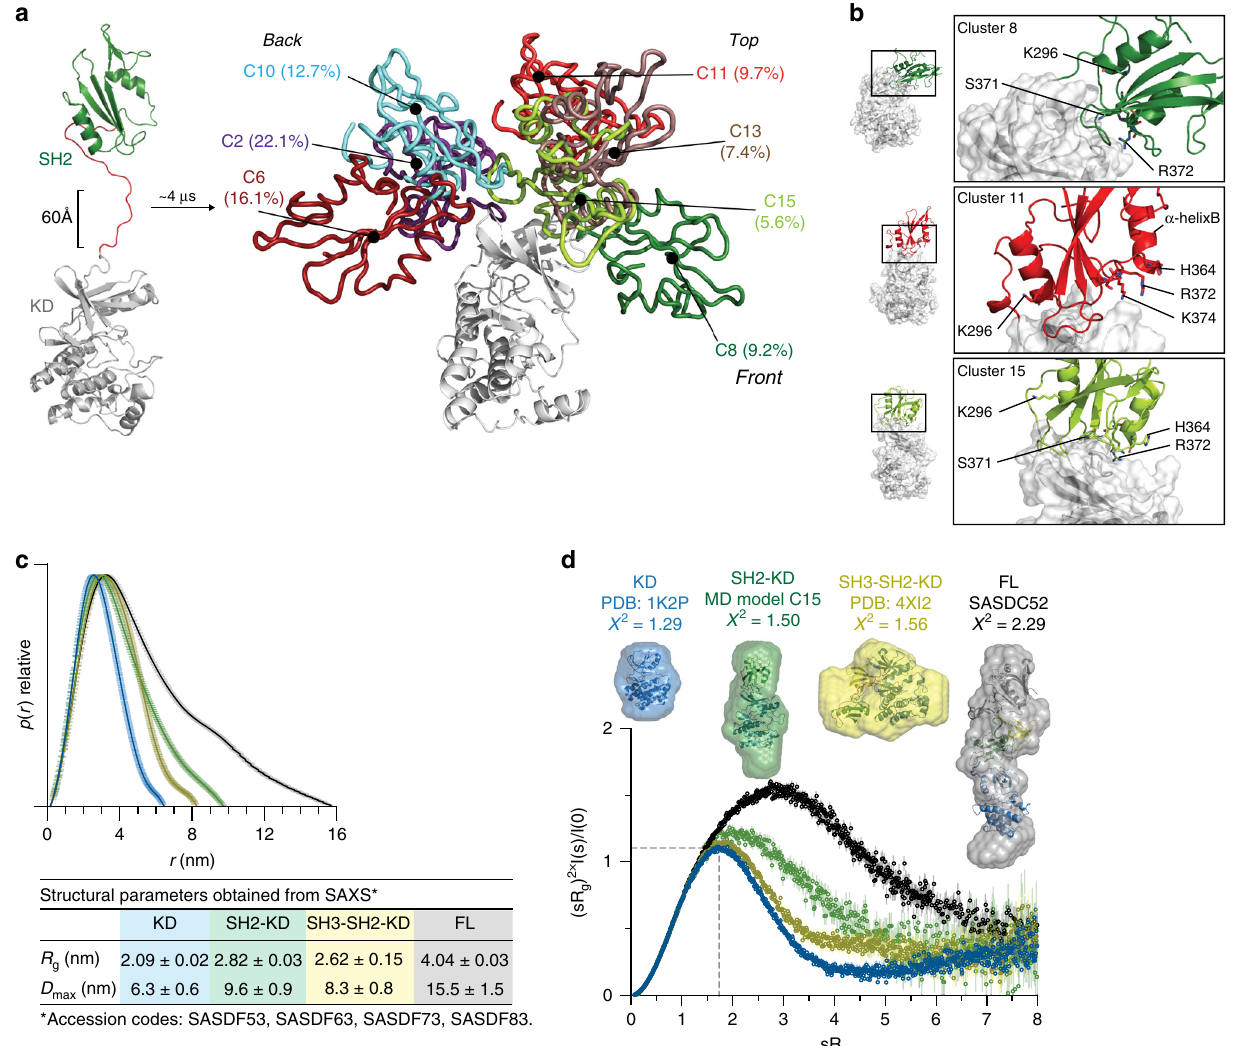
Fig. 3 SH2 domain interacts with the N-lobe of the KD in the active Btk. a Scaled MD simulations were performed using a model including the Btk SH2 and KD crystal structures (PDB 6HTF and 1K2P, respectively). The most populated clusters of the SH2 positions (several colors) relative to the KD (white) are shown. The percentages indicate the population of the cluster with respect to the entire simulation time. b Detailed view of the SH2-KD interface of clusters 8, 11 and 15. SH2 residues mutated in XLA are indicated as sticks. c Comparative maximal particle dimension ( D max ) of recombinant Btk proteins and summary of structural paraments ( R g and D max ± error) obtained from SAXS. See Supplementary Table 2 for details. d Dimensionless Kratky plot of recombinant Btk proteins. The gray dashed line represents the theoretical peak assuming an ideal Guinier region for a globular particle. Ab initio envelope reconstructions obtained from SAXS (surface representation) superimposed on the crystal structures for Btk KD and SH3-SH2-KD (PDB 1K2P and 4XI2, respectively) are shown on top. For the SH2-KD protein, the structure of an elongated MD model with the best agreement with the experimental SAXS data is shown (model C15 shown in a and b ). FL protein shows an extended conformation as observed in a previous SAXS reconstruction (SASDC52). Source data are provided as a Source Data fi